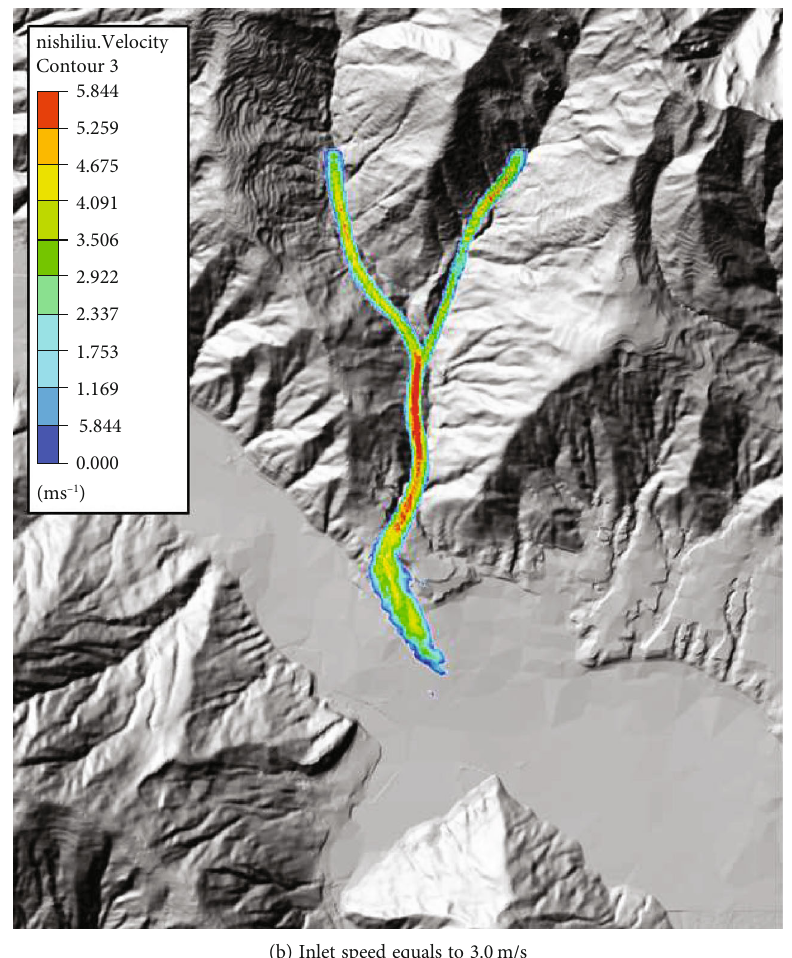
Figure 7: Velocity contour on the free surface with remote sensing image of Niwan